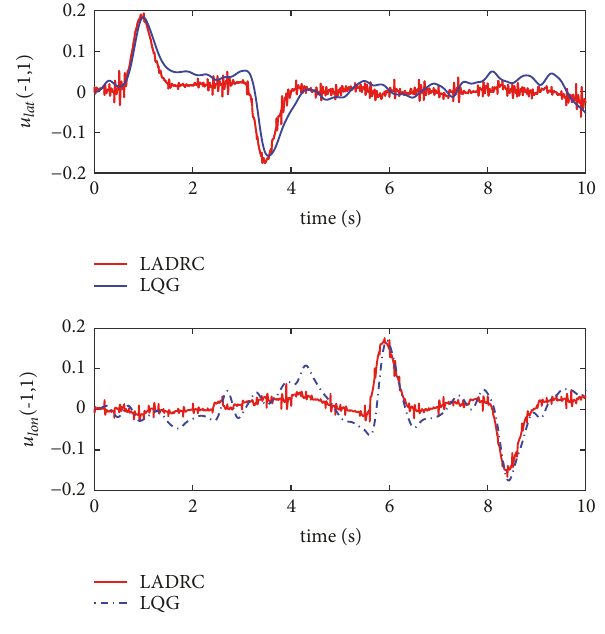
Figure 11: Control signals of both controllers.